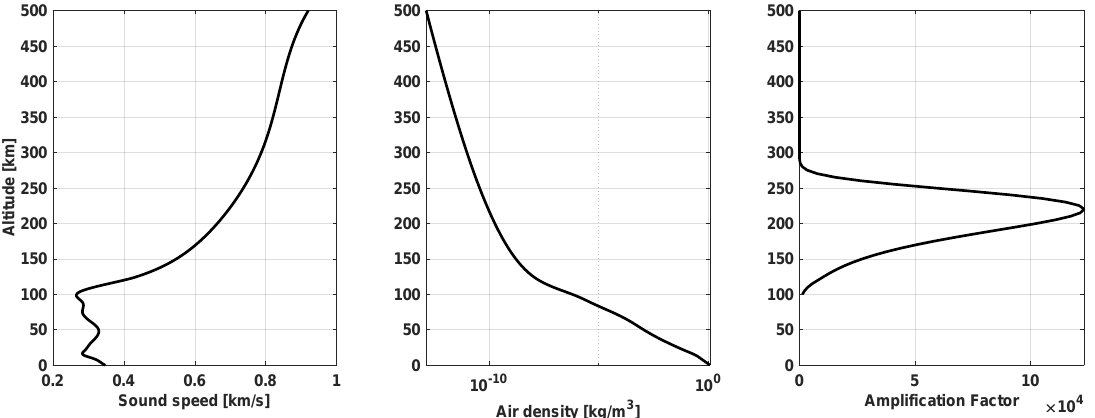
Figure 4. ( Left ) Atmospheric sound speed profile computed from the NRLMSISE-00 model [59] on 28 September 2018 at 10:02:43 UTC (18:02 Mean Local Time) above the epicenter (0.256S/119.846E); ( Center ) air density profile; and ( Right ) atmospheric amplification